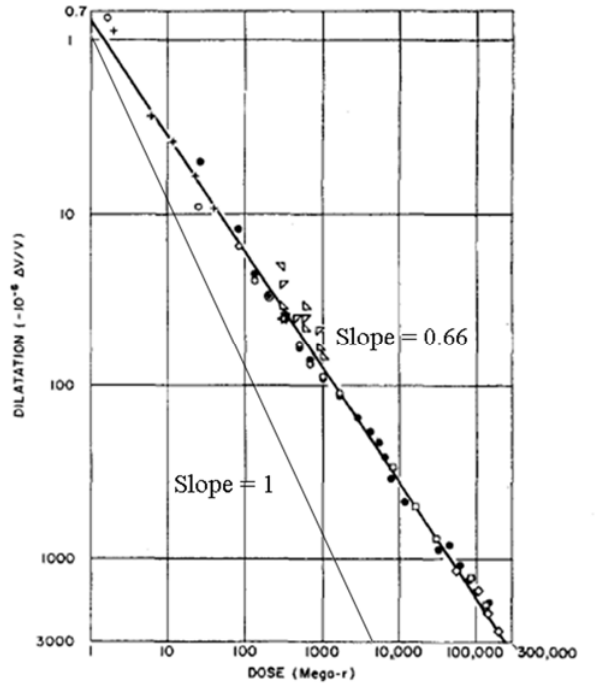
Figure 2. Electron irradiation induced compaction, reprinted with permission from [10]. Copyright 1968